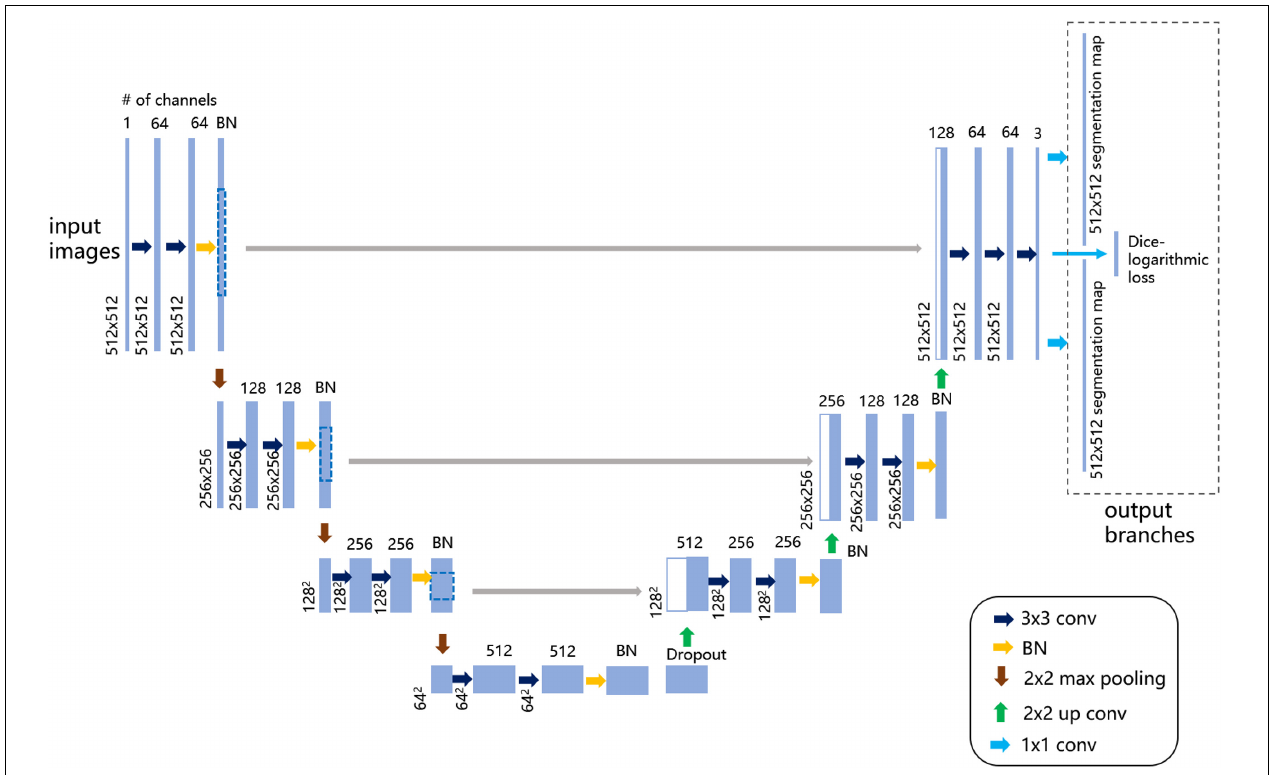
FIGURE 2 | Illustration of the revised U-Net architecture for multilabel semantic segmentation. The figure demonstrates the architecture with the largest patch size of 512 × 512 voxels as input images on the left. Each light blue solid box corresponds to a multichannel feature map, as the channel number is denoted on top of the box and the image dimensionality is denoted on the left edge. The white boxes with light blue lines represent the concatenated copied feature maps from the contractive path. On the upper right, the dashed-line box represents the output branches consisting of two segmentation maps and one extra layer to compute the customized loss function. The colored arrows represent the different operations listed in the lower-right